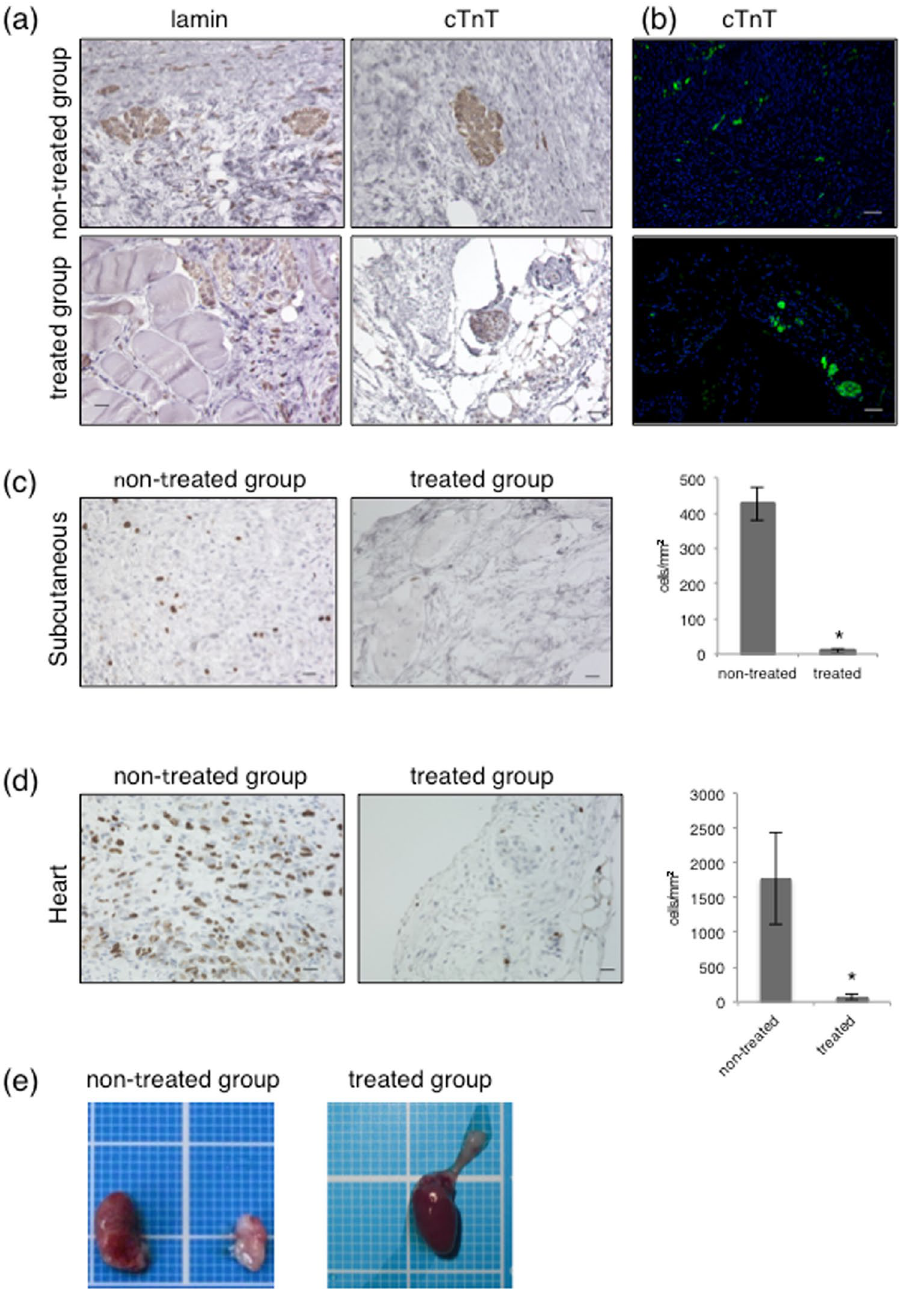
Figure 7. Effect of brentuximab vedotin on teratoma/tumour formation. Teratoma formation in NOG mice 4 months after transplantation of hiPSC-derived CMs with or without brentuximab vedotin treatment. ( a ) Representative images of subcutaneous tissue stained with antibodies against human-specific lamin and cardiac troponin T. Scale bars, 20 μ m. Positive cells are seen as dark brown. ( b ) Representative images of cTnT-positive cells. Scale bars, 50 μ m. Positive cells are seen as green. ( c ) Representative images of subcutaneous tissue stained with antibody against Ki-67. Scale bars, 20 μ m. Positive cells are seen as dark brown. The number of Ki-67– positive cells in the subcutaneous tissue was calculated. * p < 0.01 vs. non-treated group ( d ) Representative images of heart tissue stained with antibody against Ki-67. Scale bars, 20 μ m. Positive cells are seen as dark brown. The number of Ki-67 positive cells in the heart was calculated. * p < 0.01 vs. non-treated group ( e ) Representative images of tumour formation in the heart of NOG mice. hiPSC-derived CM sheets with or without brentuximab vedotin treatment were